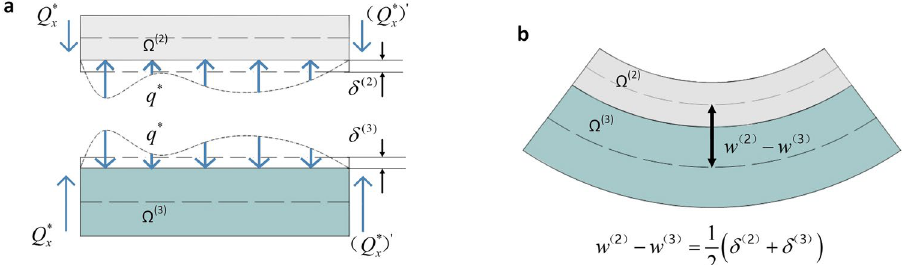
Figure 2. Illustration of the deformation mechanism in one of the contact regions R ∈ [ x , x + Δ x ] between Sub-laminates Ω (2) and Ω (3) during vibration. ( a ) Local interaction kinematics at the interfaces of Sub-laminates Ω (2) and Ω (3) . ( b ) A compatiable deformation between macro deflection and micro local deformation of Sub- laminates Ω (2) and Ω (3)